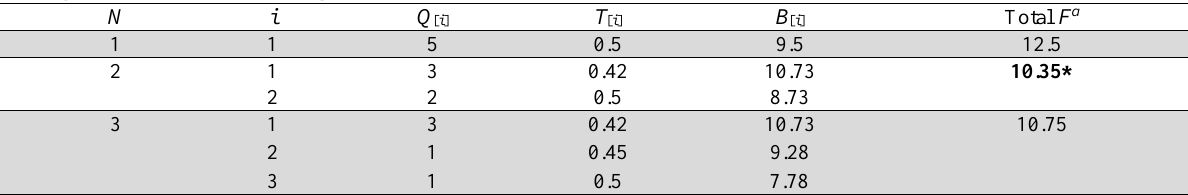
Testing Results of the H-Algorithm